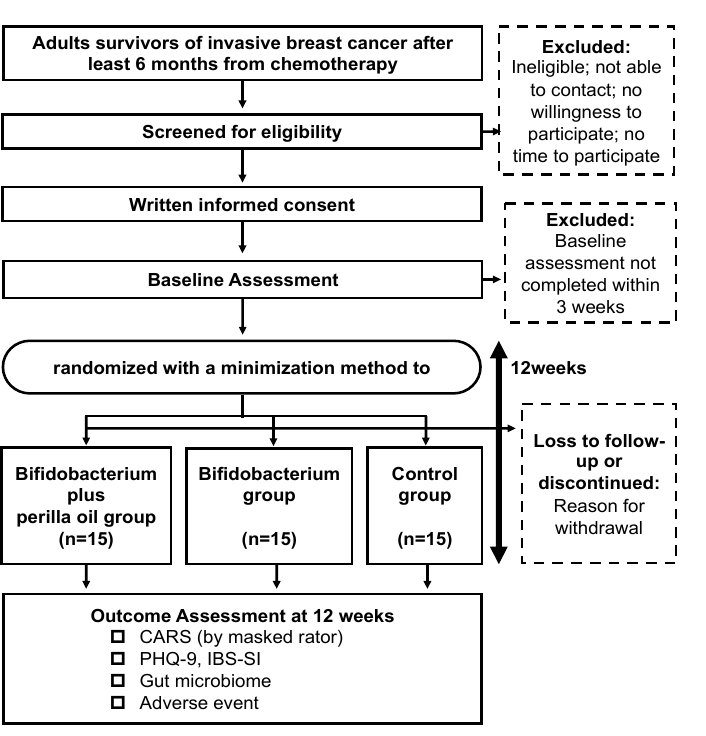
Figure 1. Flowchart of this trial.